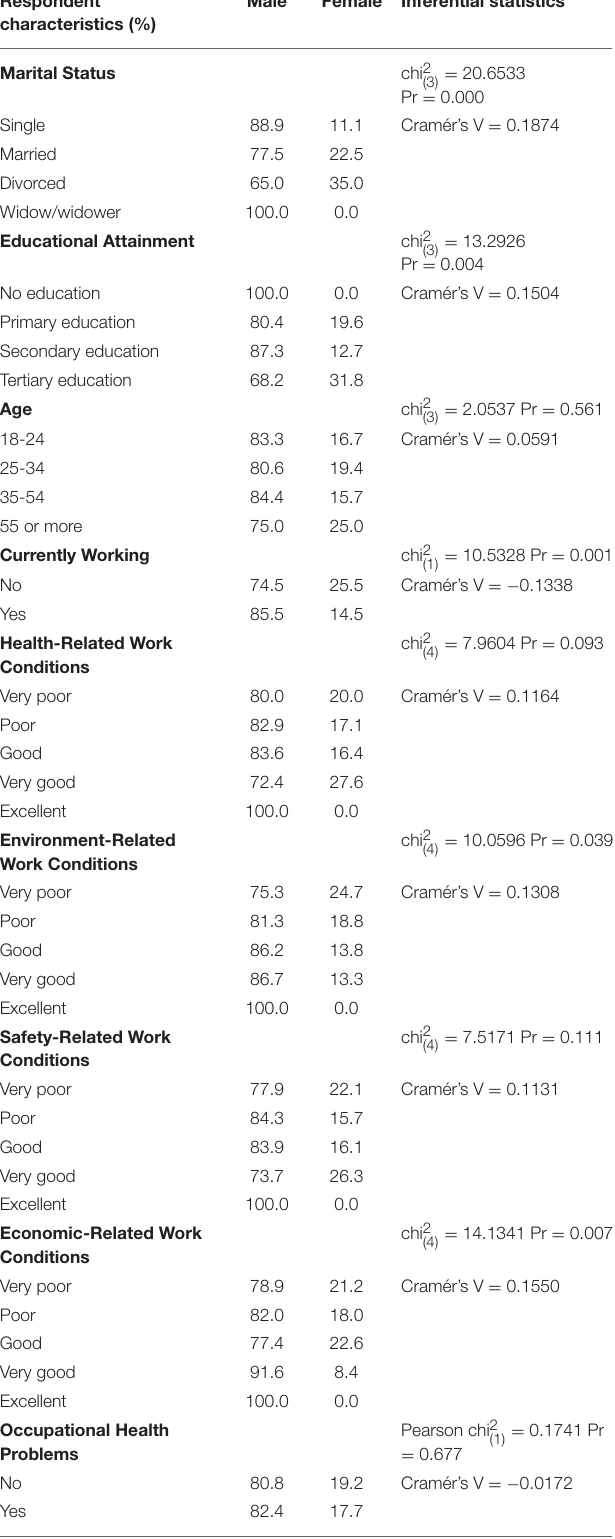
TABLE 1 | Sample characteristics of artisanal gold